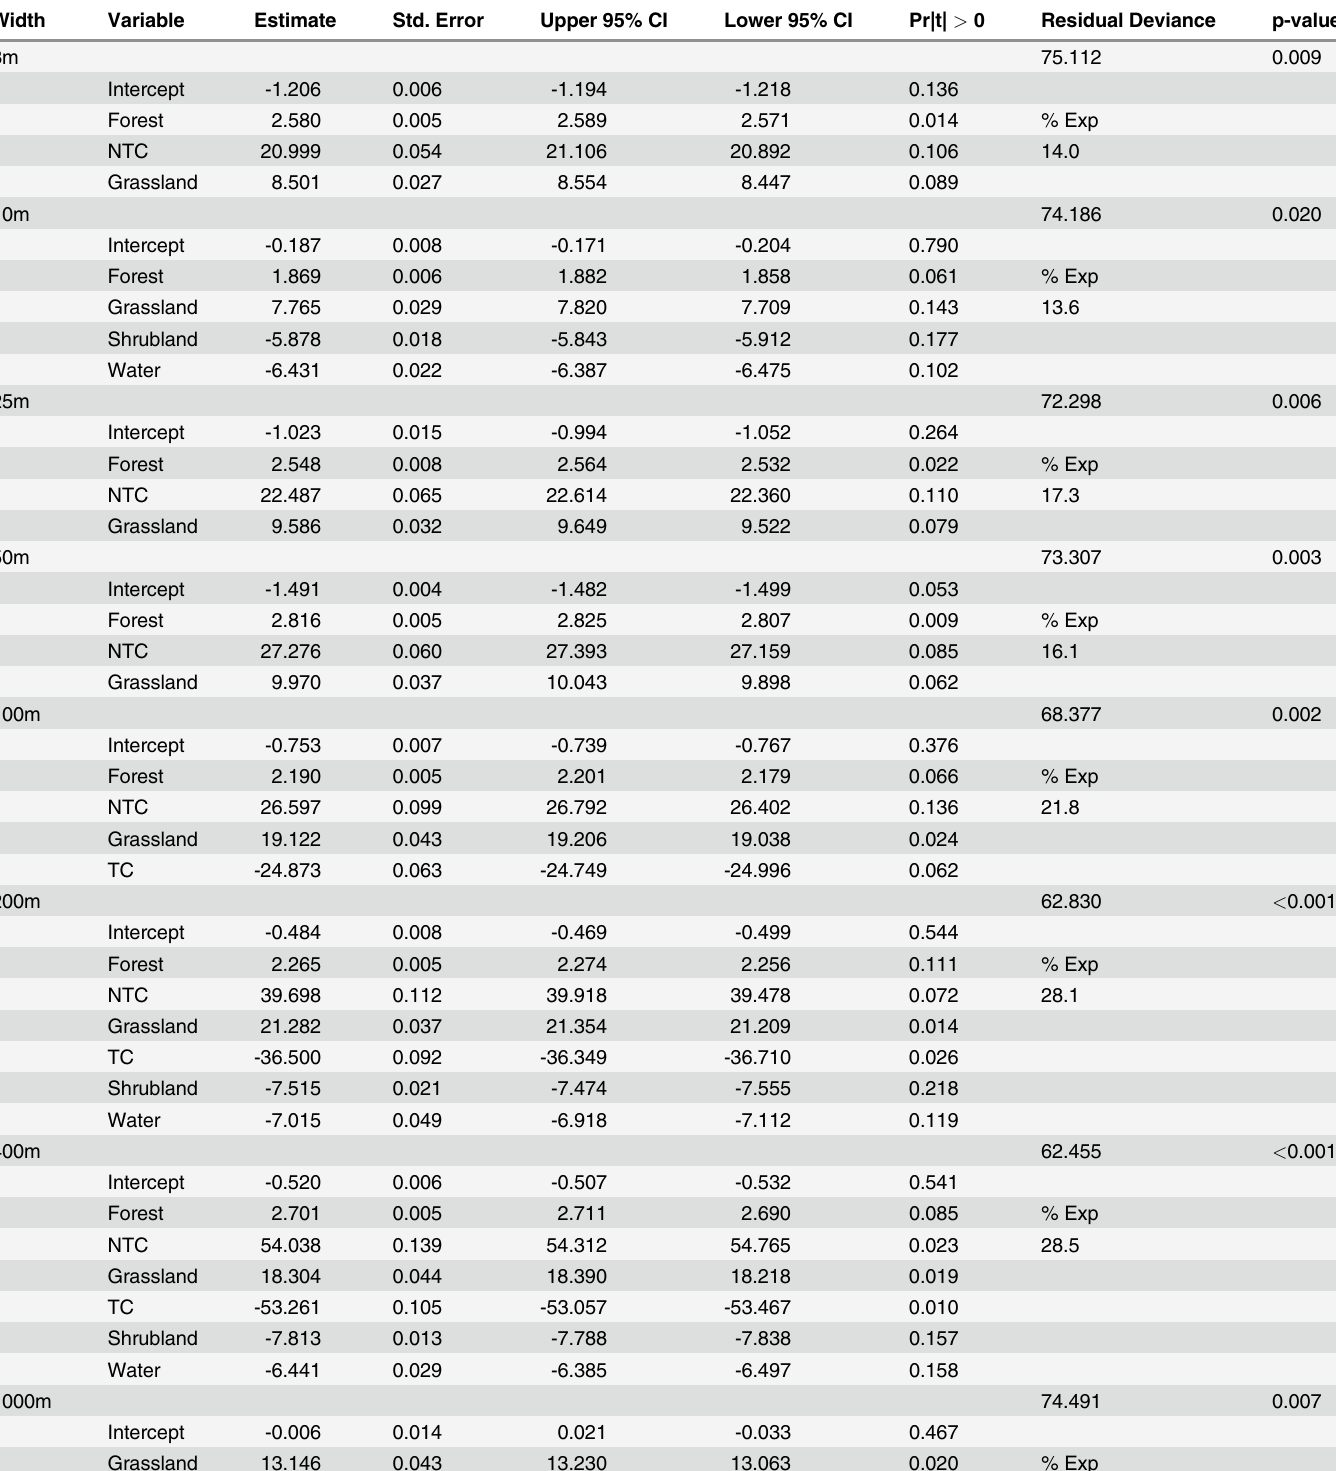
Table 1. Final logistic regression models for habitat prediction of segment category in eastern chipmunks after stepwise selection from full models with response variable 0 = between population segment, 1 = within population segment.